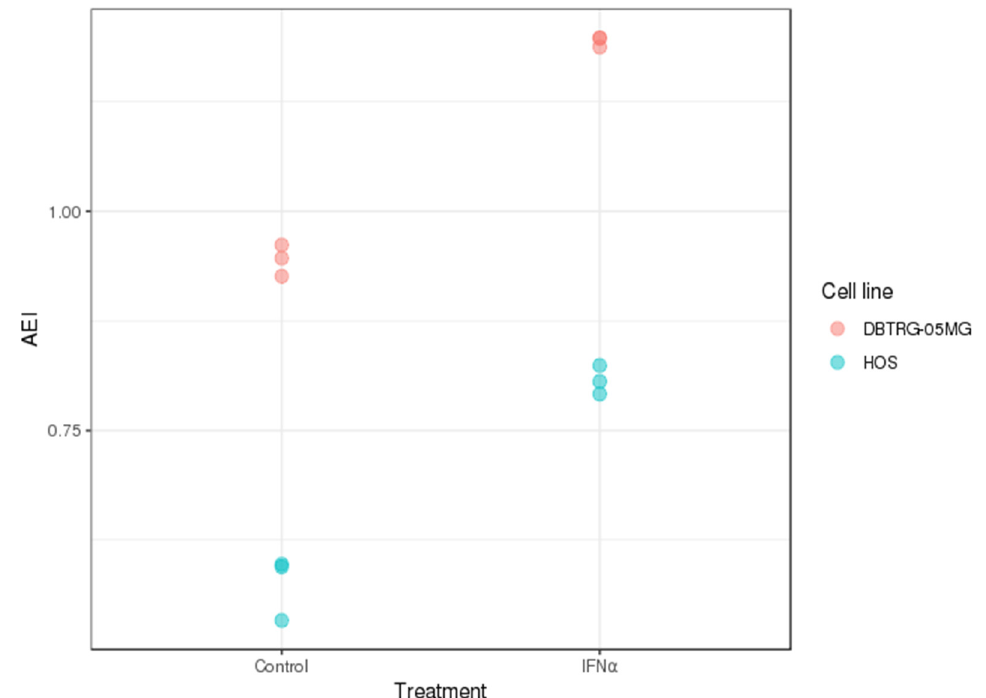
Figure 4. Alu RNA editing indices (AEI) [23] for DBTRG-05MG and HOS cells before and after interferon α 2 β treatment, which are intended to be surrogate markers for an enzymatic function of ADAR1. Despite the higher basic levels of ADAR activity in the glioma cell line, both cell lines demonstrated approximately equal induction of this activity under treatment. Each state on the graph is represented by data from three biological replicates of the transcriptome.